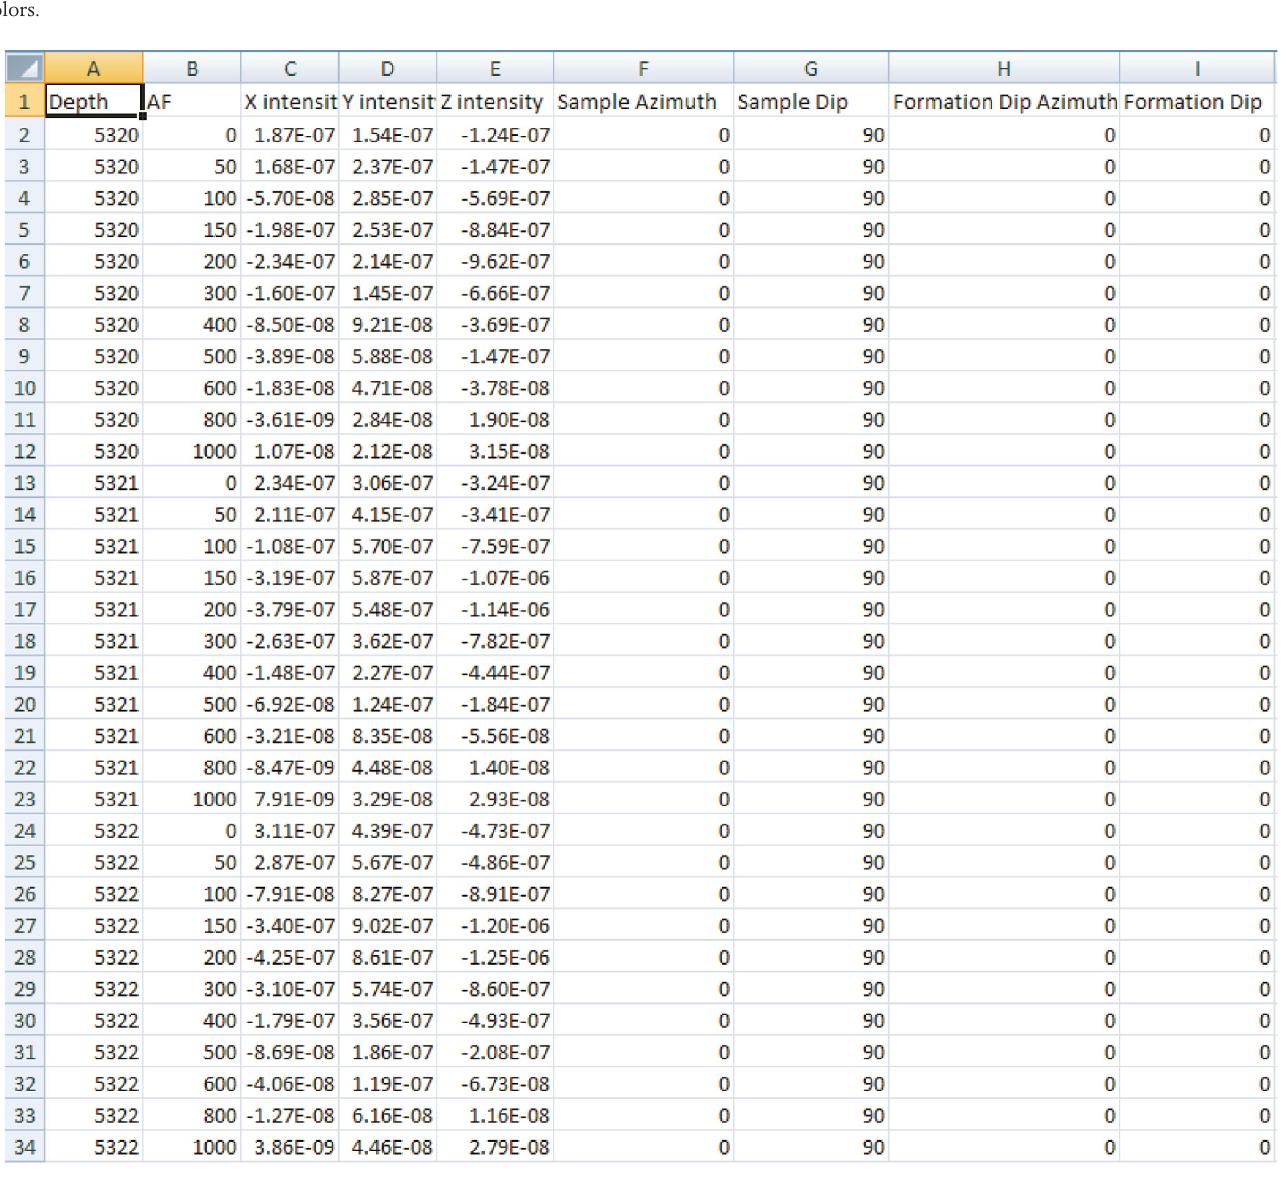
Figure 1. The modular structure of the DAIE workbook. The workbook consists of 10 worksheets which are organized in 3 groups marked with distinct colors.